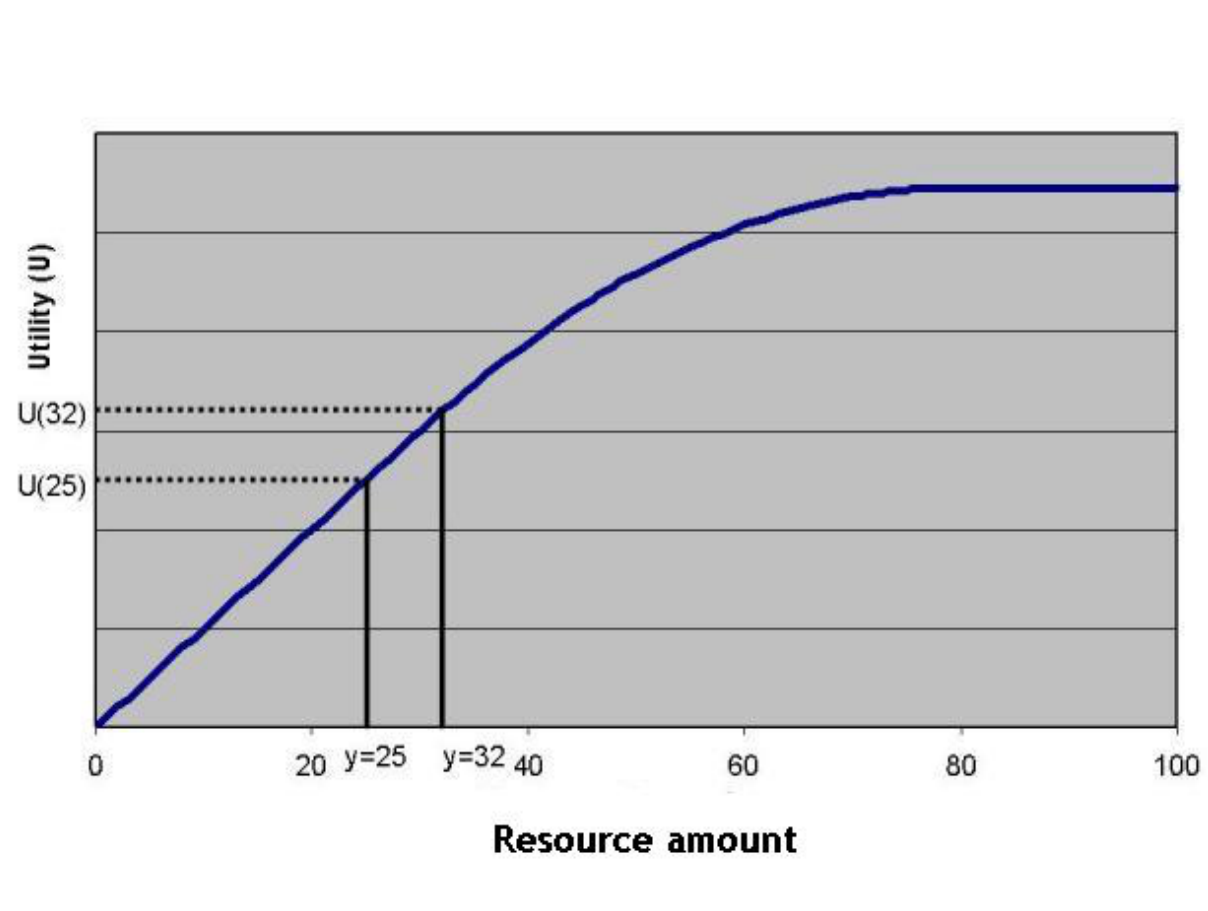
Fig.1. A hypothetical conservation utility